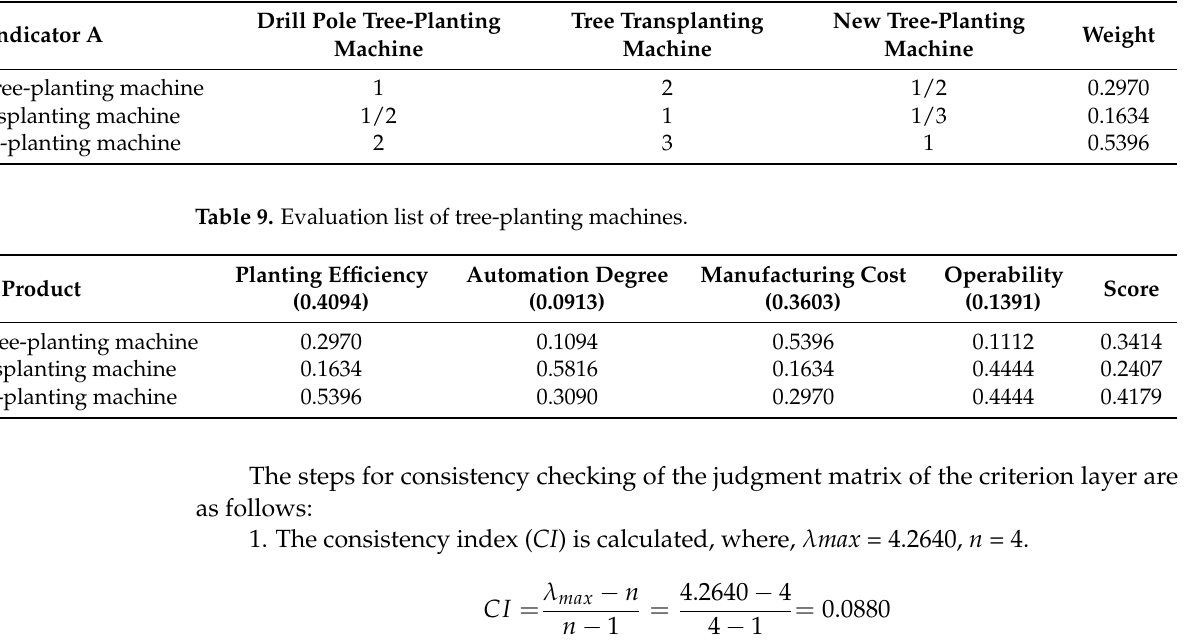
Table 8. Judgment matrix of the scheme layer regarding the planting efficiency.